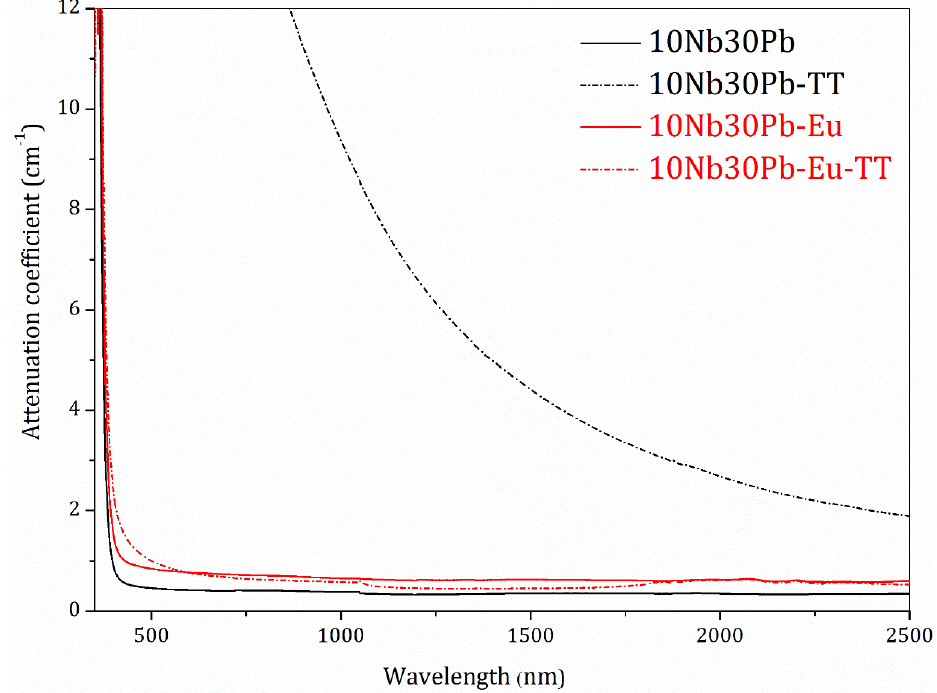
Figure 9. UV-visible spectra of glasses 10Nb30Pb, 10Nb30Pb-Eu, and glass-ceramics 10Nb30Pb-TT, 10Nb30Pb-Eu-TT.